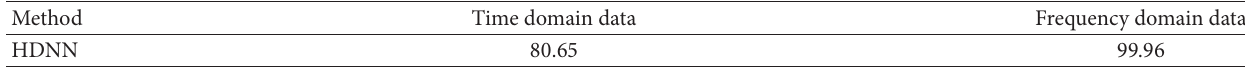
Table 4: Accuracy of classification in time domain and frequency domain.